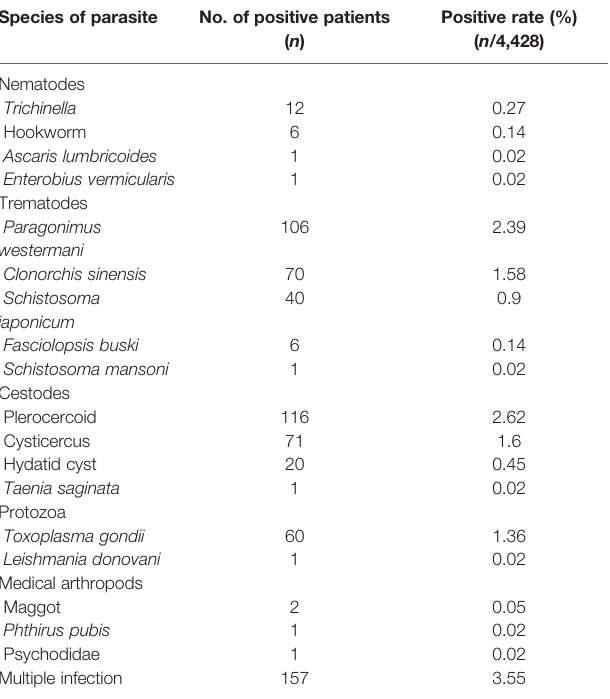
TABLE 2 | The species of parasites detected and the positive